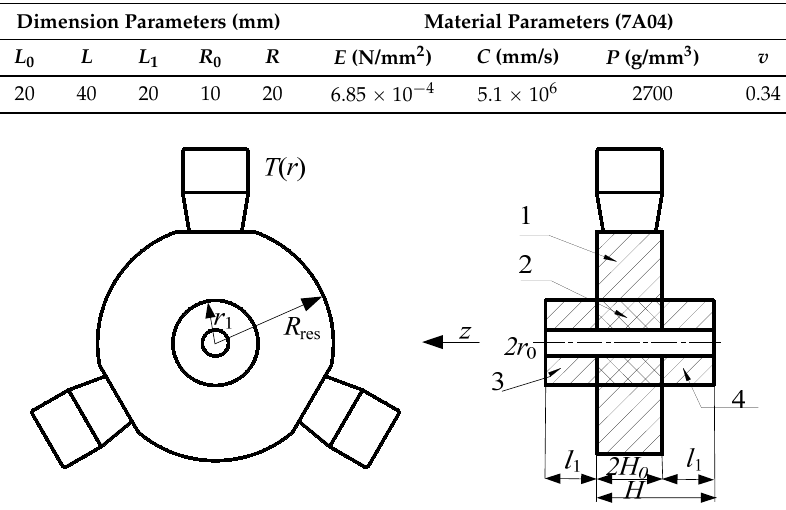
Table 1. Dimension and material parameters of power-superimposed ultrasonic vibrator.